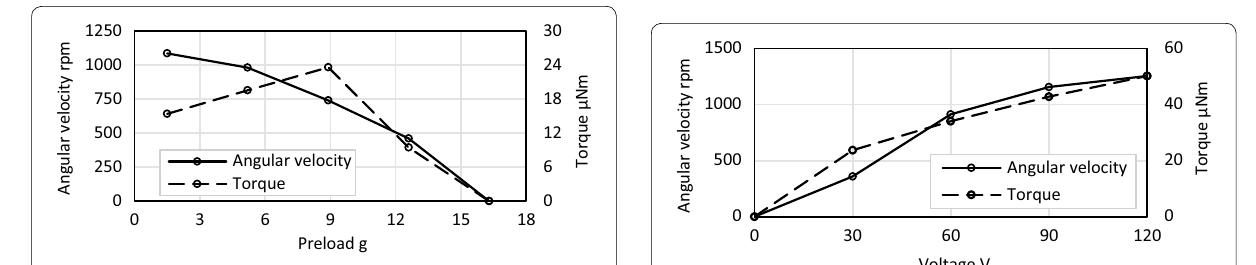
Fig. 11 Behavior of the angular velocity and the torque generated by the ultrasonic motor using the cubic bulk stator when the preload changes